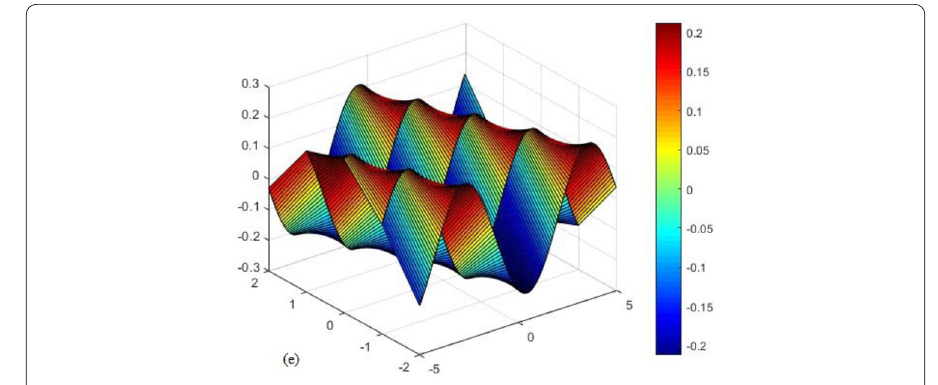
Figure 6 The graph of approximate solution ( e ) of (cid:13) ( χ , ϕ , η ) at ϒ = 0.4 of Example 1